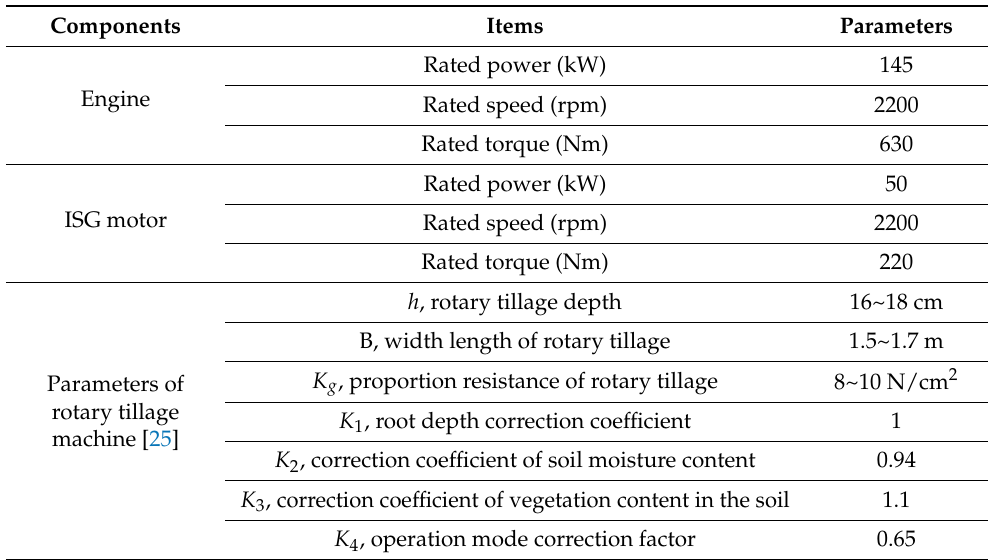
Table 3. The main parameters of rotary tillage operation